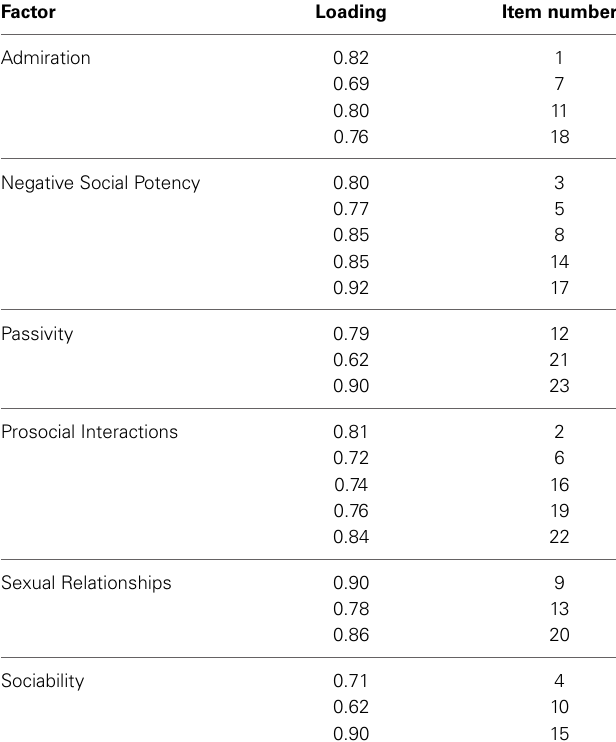
Table 2 | Standardized factor loadings from the six-factor